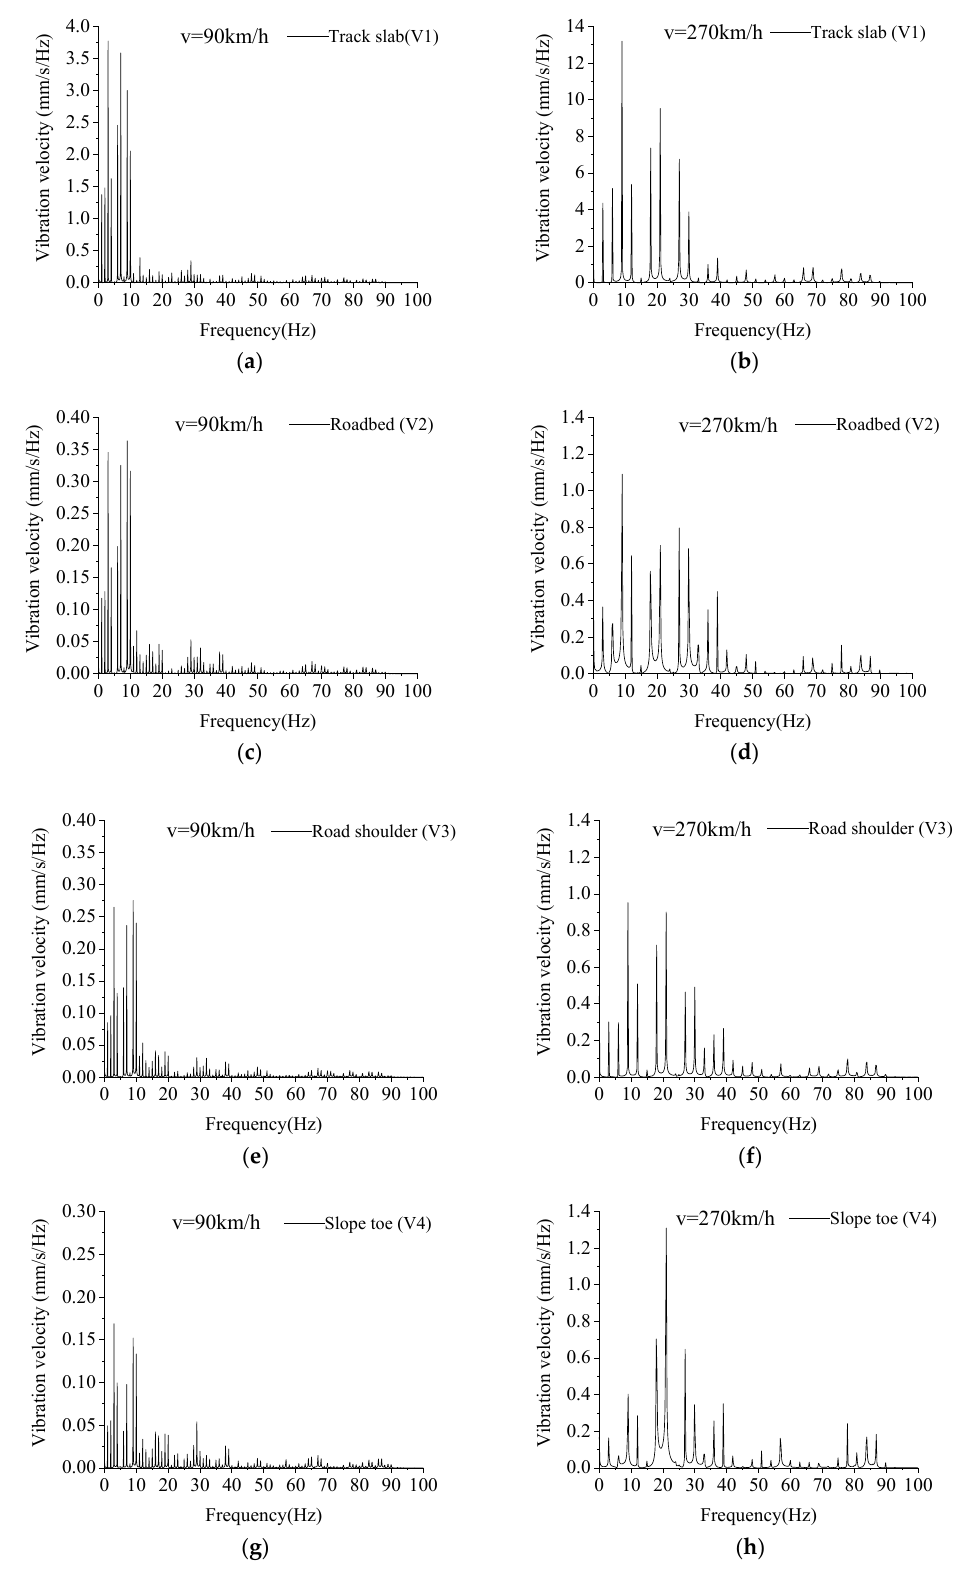
Figure 8. Frequency spectrum analysis of vibration velocities at the track slab, roadbed, road shoulder, and slope toe for different train speeds. ( a ) Track slab (V1, v = 90 km/h), ( b ) Track slab (V1, v = 270 km/h), ( c ) Roadbed (V2, v = 90 km/h), ( d ) Roadbed (V2, v = 270 km/h), ( e ) Road shoulder (V2, v = 90 km/h), ( f ) Road shoulder (V3, v = 270 km/h), ( g ) Slop toe (V4, v = 90 km/h), ( h ) Slop toe (V4, v = 270 km/h).